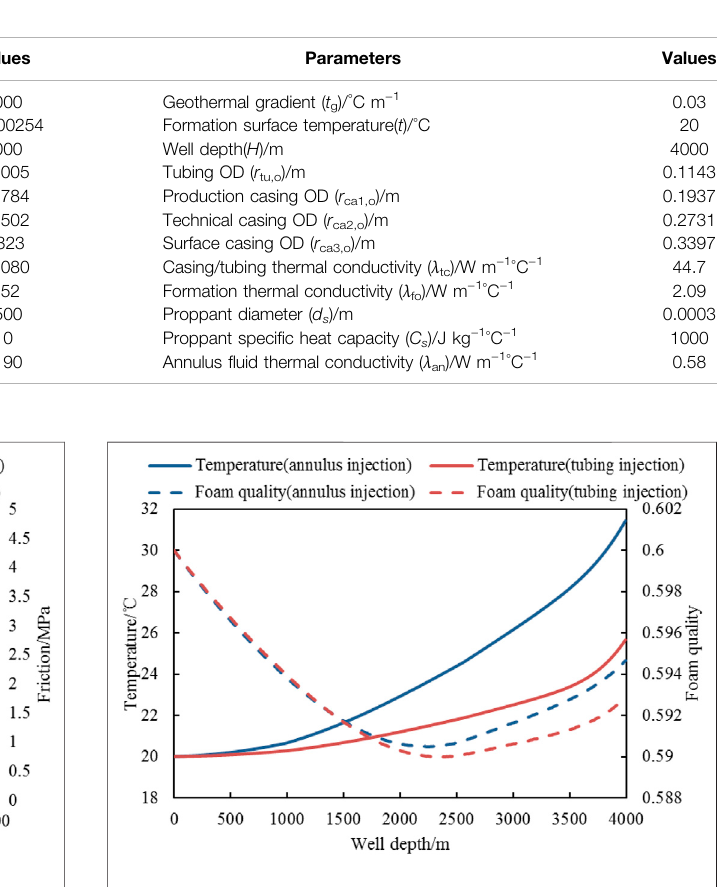
FIGURE 6 | Changes in temperature and foam quality under different injection